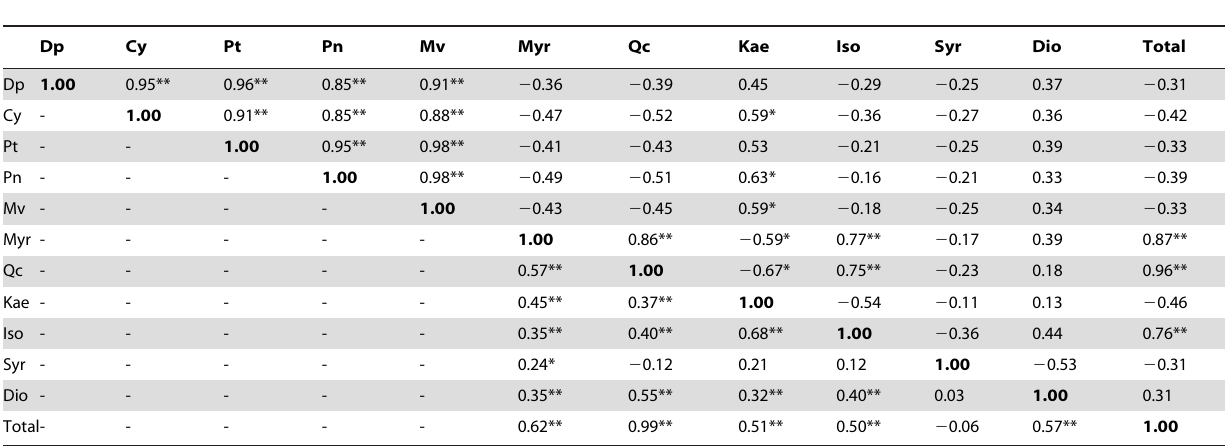
Table 3. Correlation coefficients of each flavonoid derivative in petals of all studied cultivars (above diagonal) and of each flavonoid derivative in other tissues (below